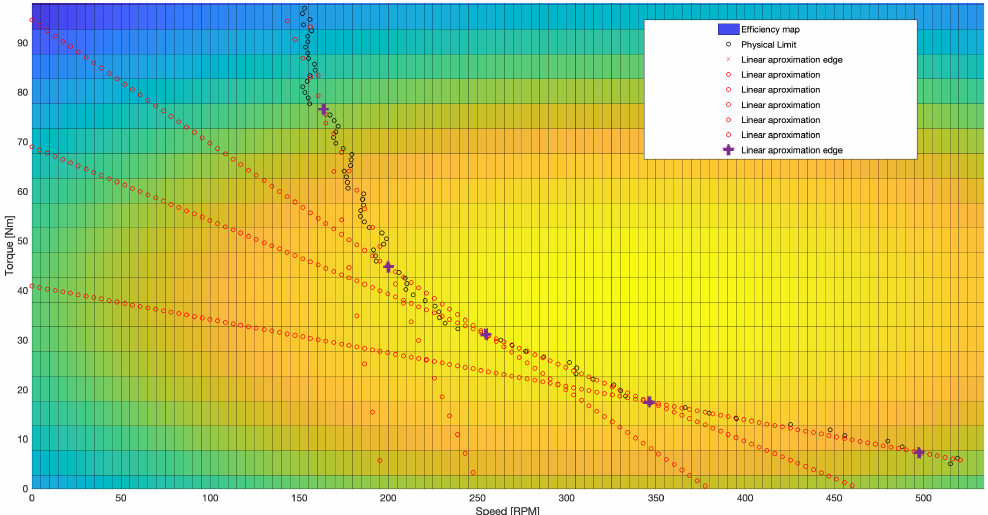
Figure 10. Simplified efficiency